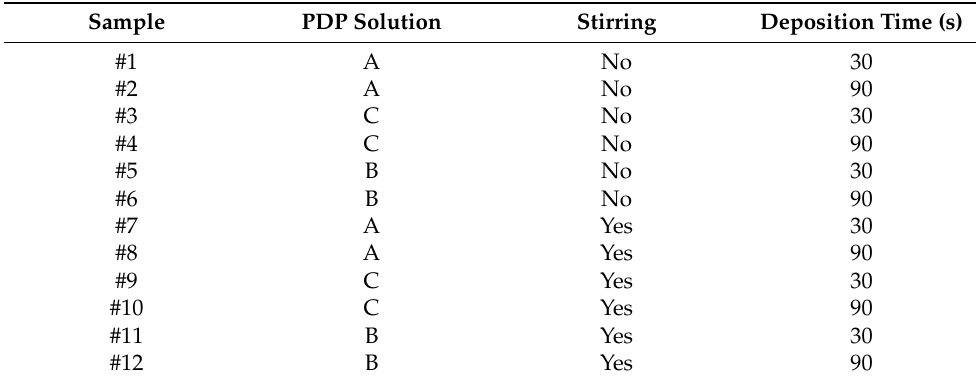
Table 3. Deposition conditions for PDP samples obtained from baths A, B and